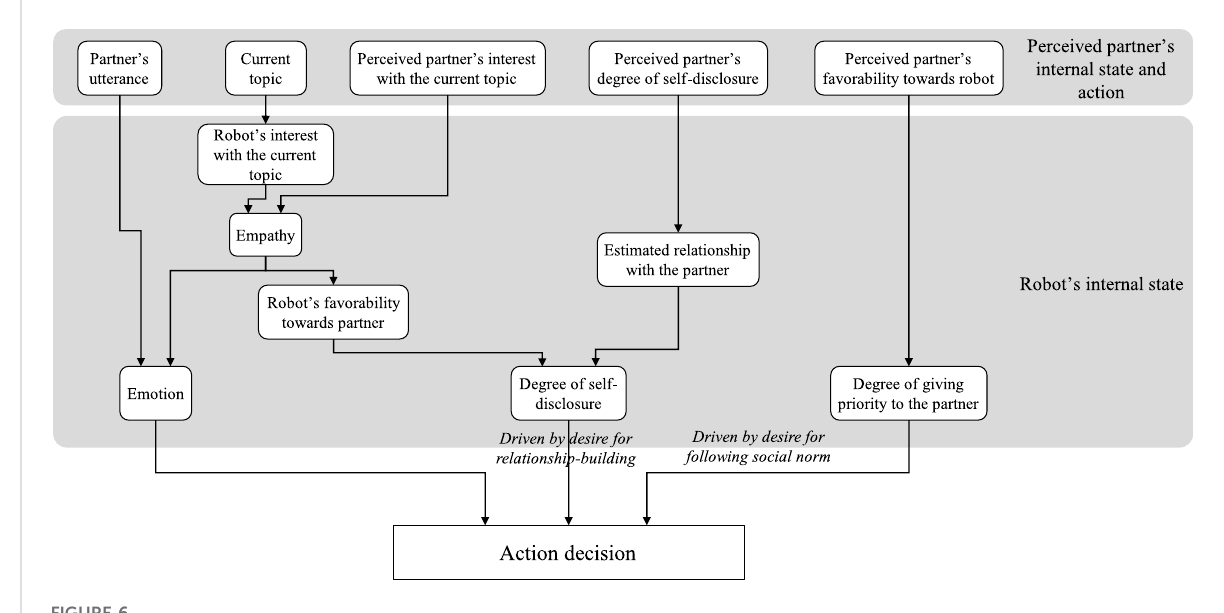
FIGURE 6 Implementation of the robot ’ s action decision based on its desire in the fi rst-meeting